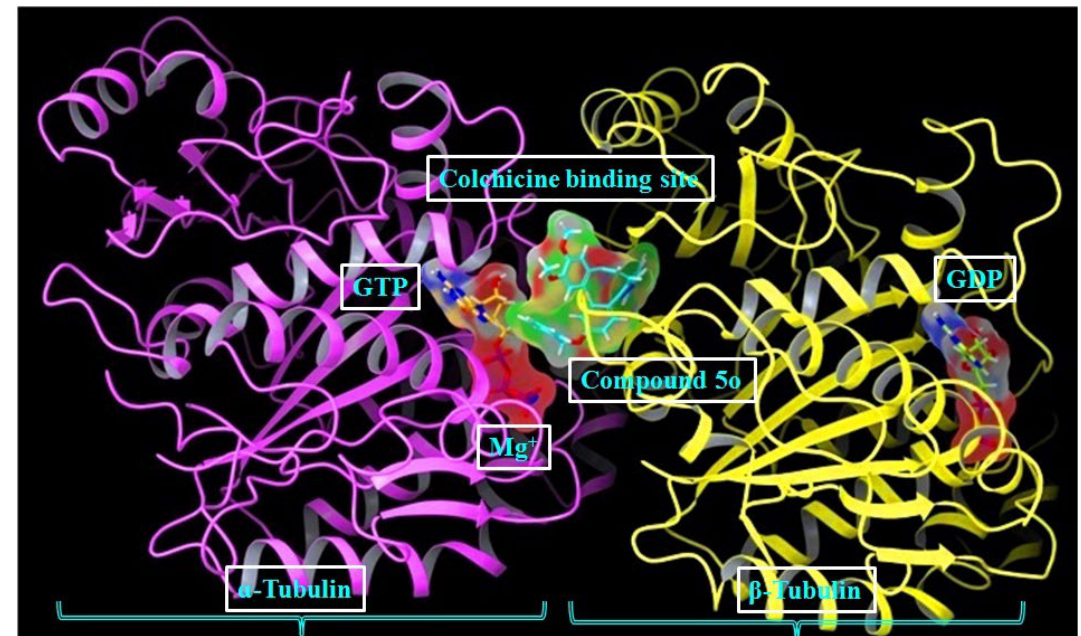
Figure 3. Different binding sites of tubulin protein complexes with 5o (turquoise-color stick model), GTP, Mg +2 , and GDP. The α -chain is represented in purple color and the β -chain is represented in yellow color.